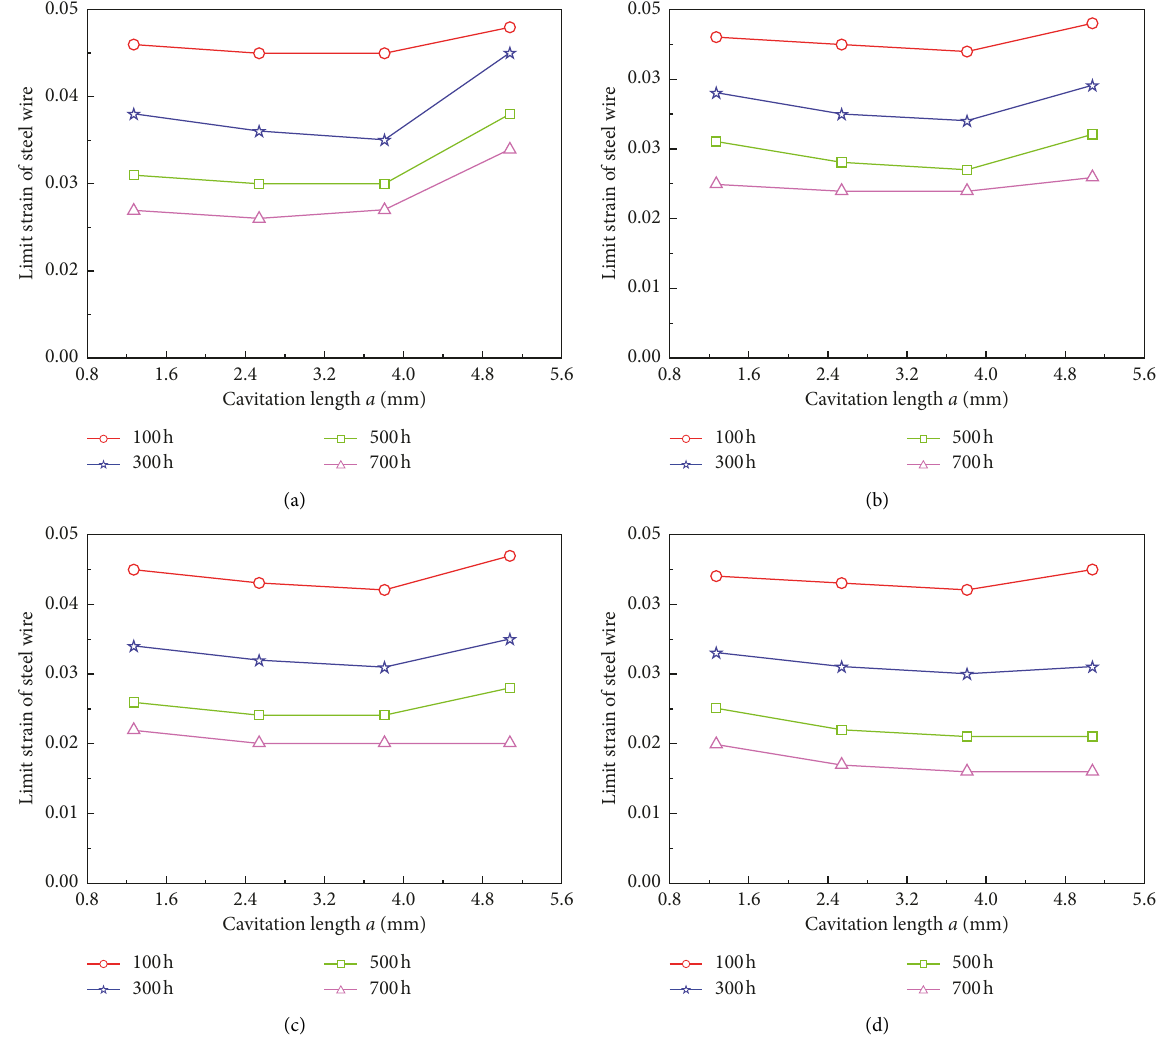
Figure 14: Influence of pitting length on the ultimate strain of steel wire under different working conditions.